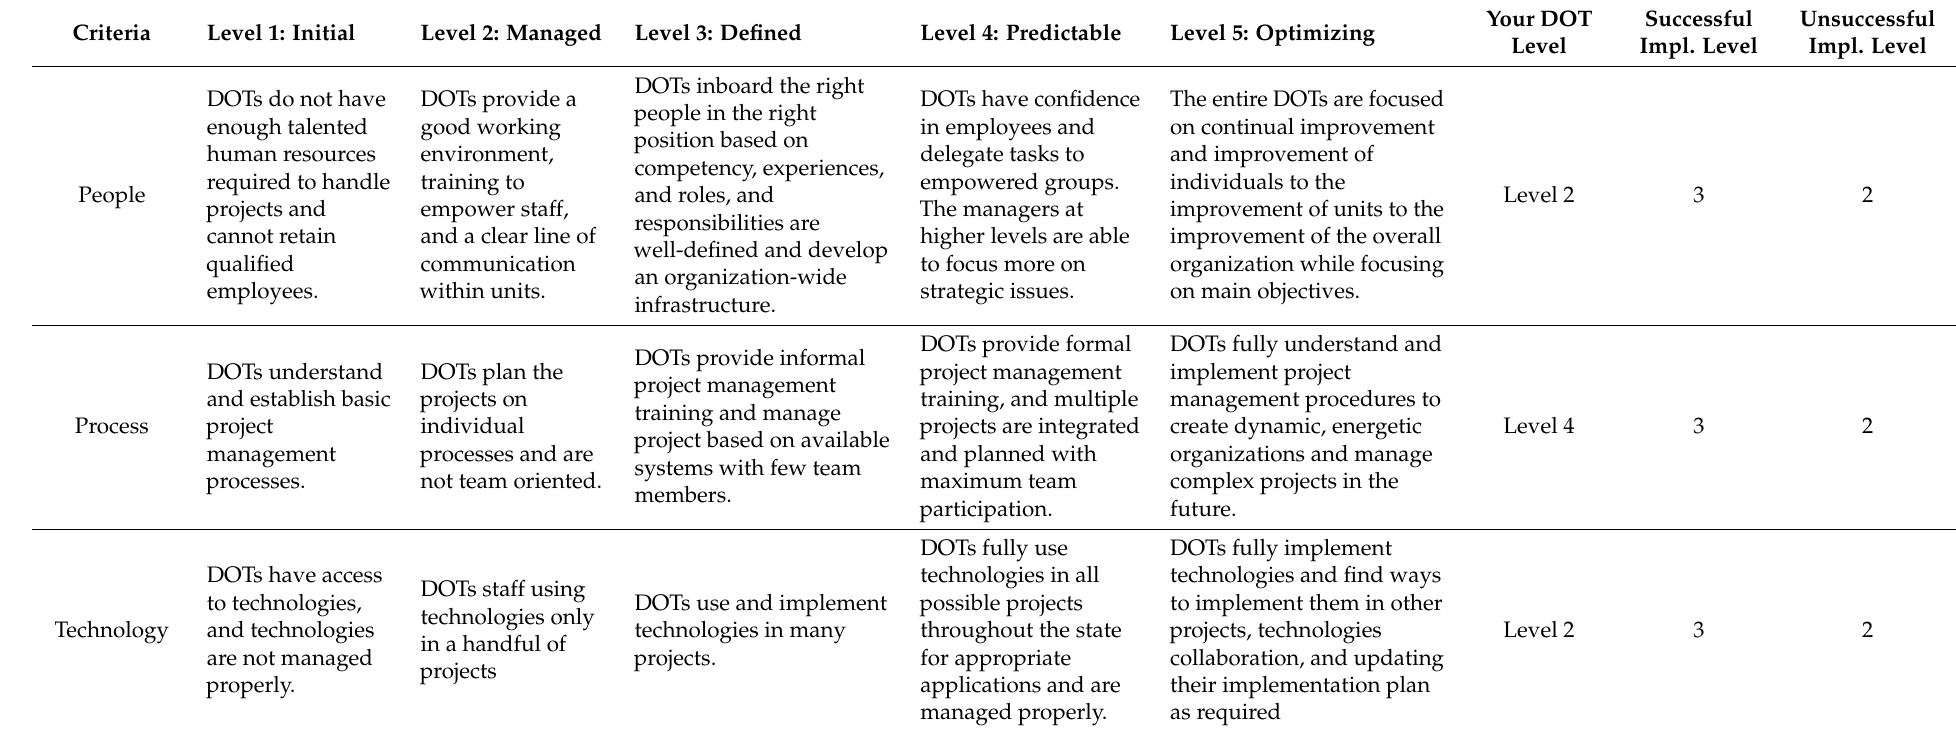
Table 7. Self-assessment of state DOTs for Technology